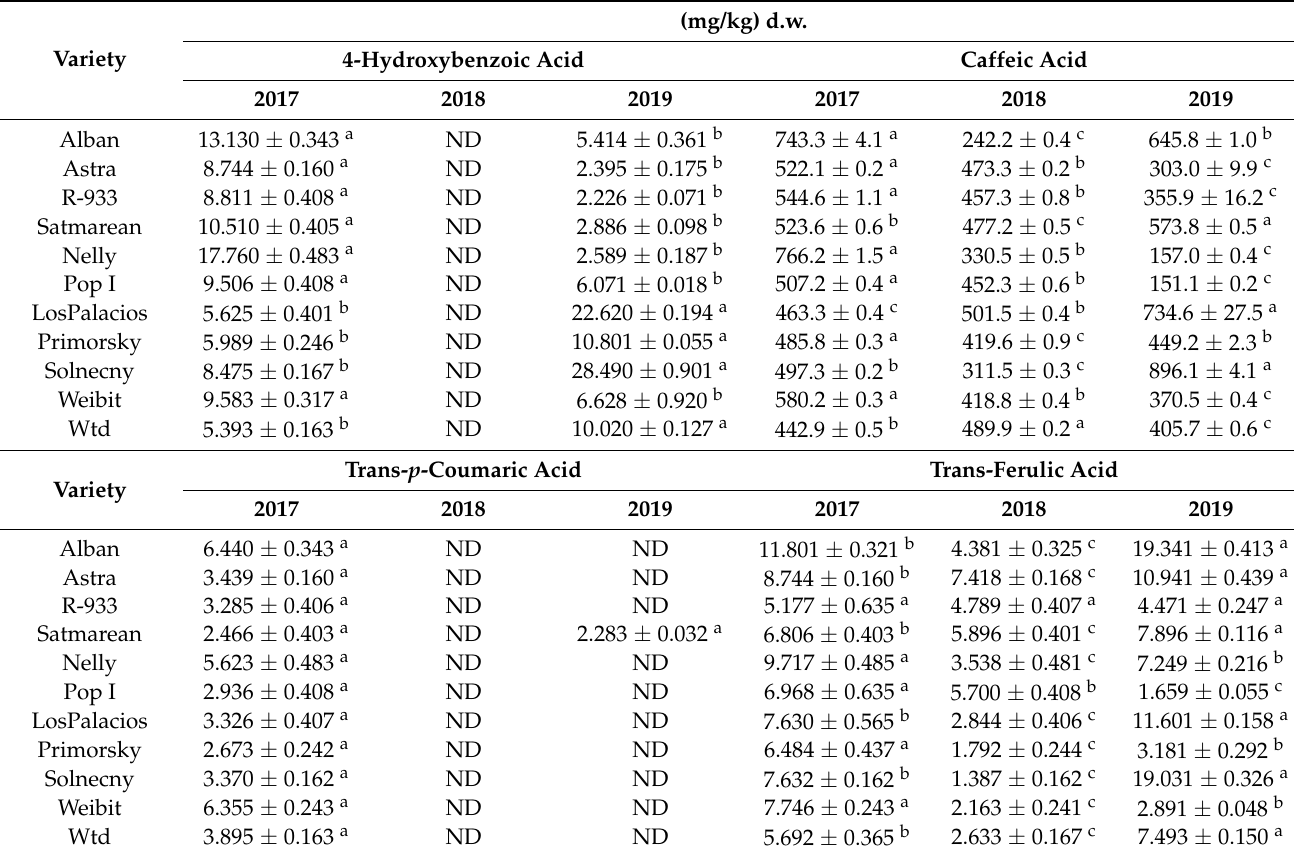
Table 4. Influence of the year of cultivation of phenolic acids contents in monitored varieties of lupin (mg/kg d.w., means ± standard deviations of four independent determinations). (mg/kg)